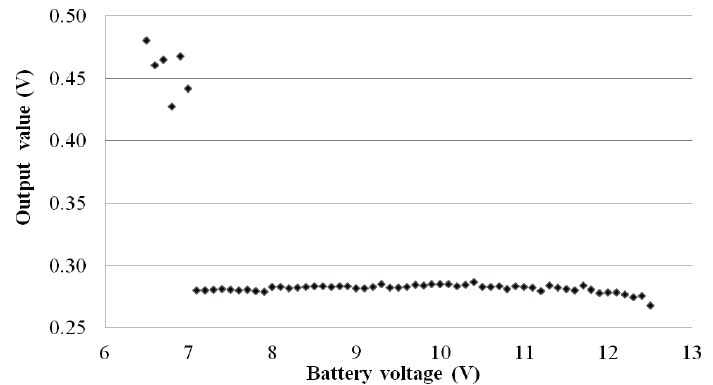
Figure 13. Effect of battery residual charge on sensor